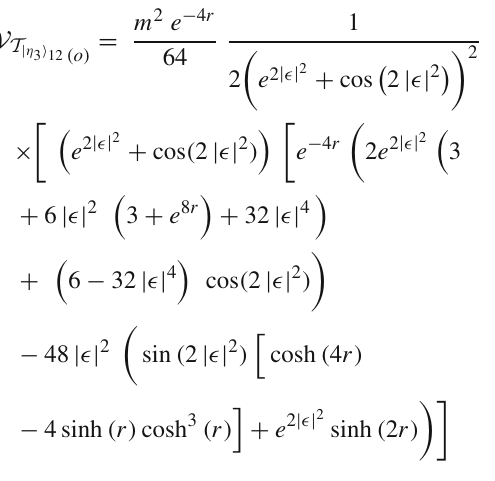
with m τ = x and in the limit x (cid:14) 1 the equation further reduces